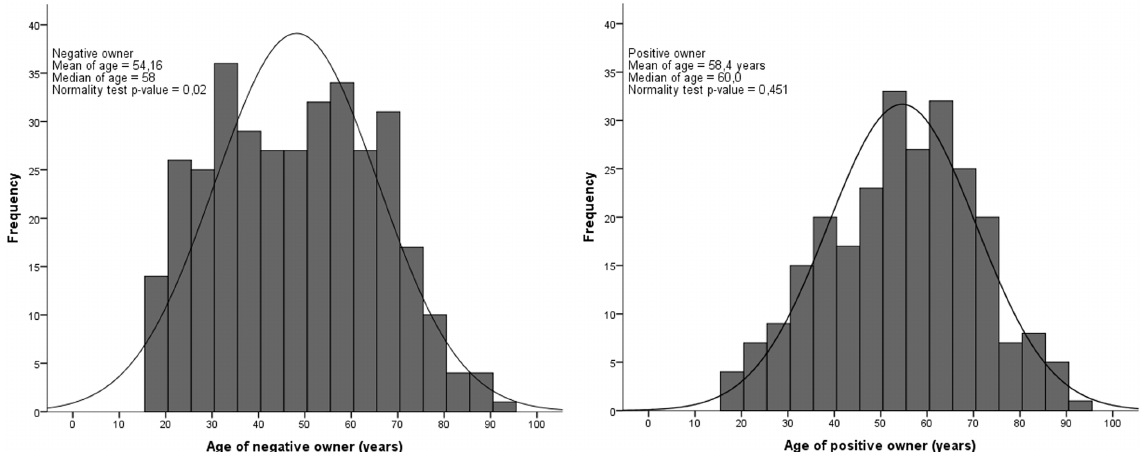
Fig 1. Histogram of age for positive and negative owners for T . gondii serology in the urban area of Londrina, from July 2015 to July 2016.